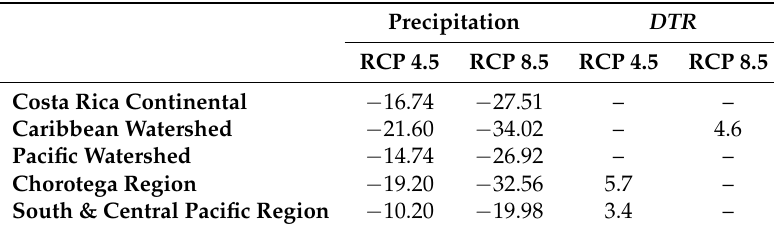
from 1950–2100 using the Mann–Kendall test at the 95% confidence